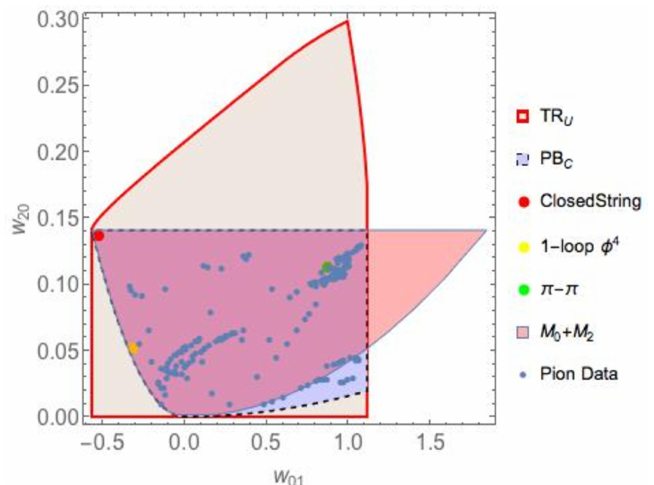
Figure 5. The comparison of plots for w 20 vs w 01 for our case and the one in